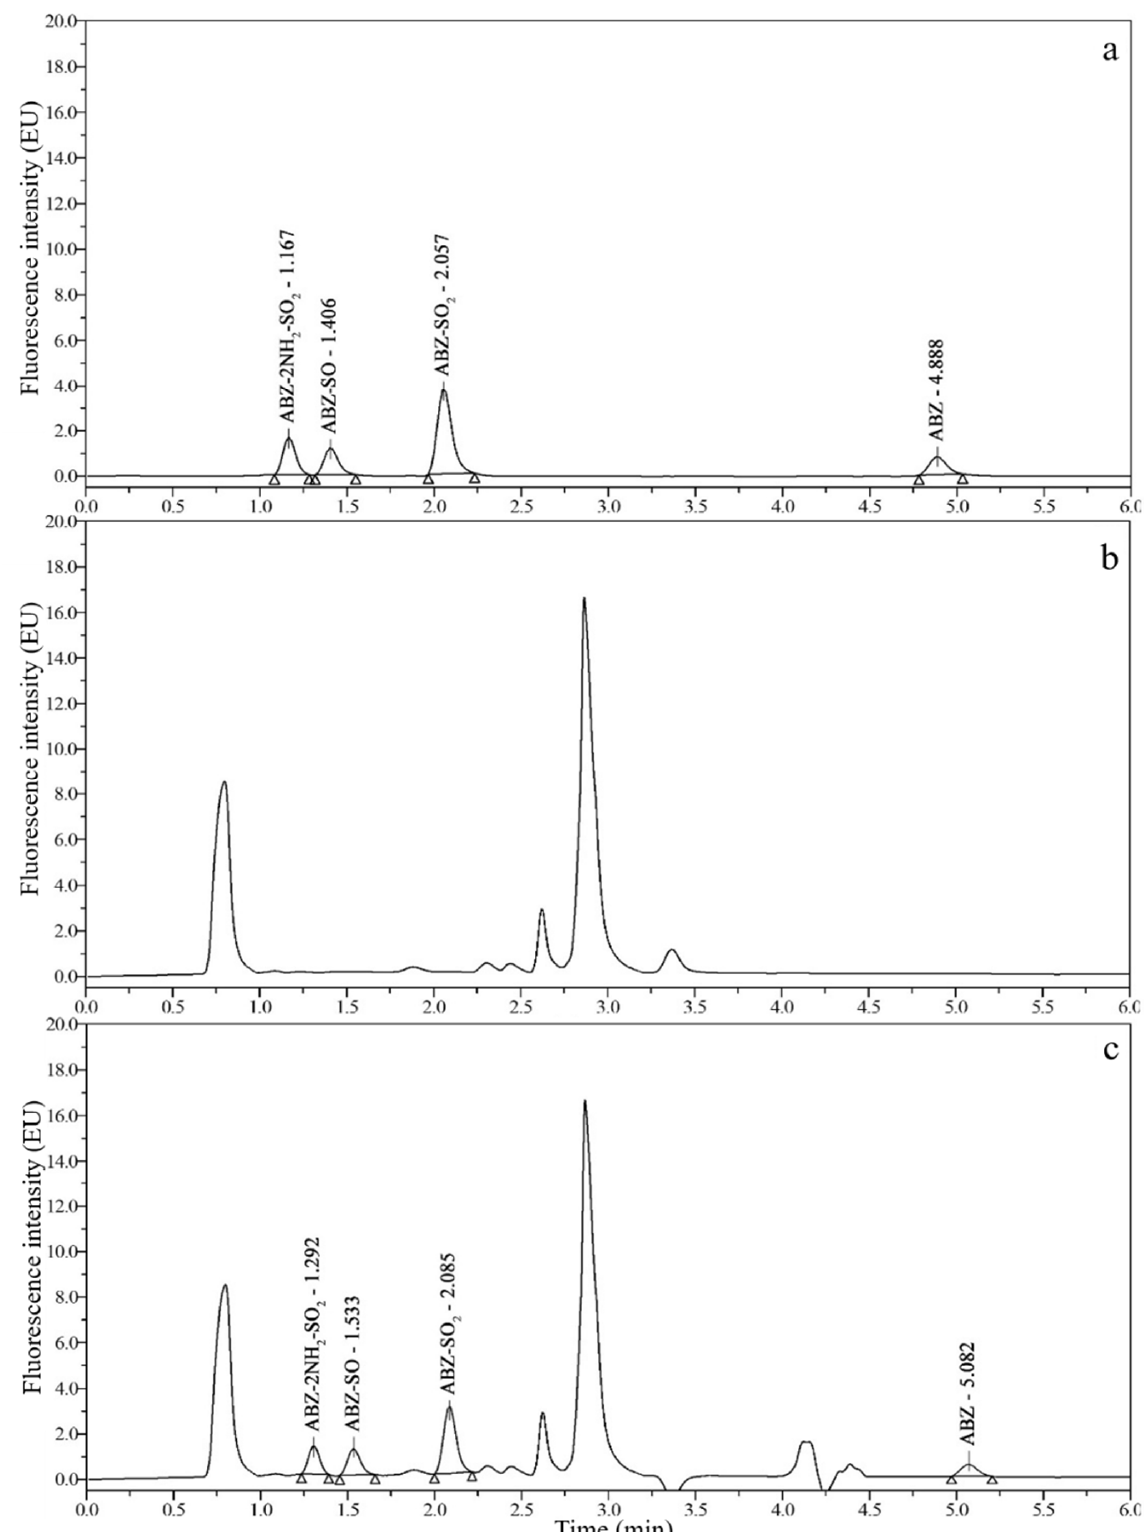
Figure 2. Chromatograms of 10 µ g/kg ABZ-2NH 2 -SO 2 , 50 µ g/kg ABZ-SO, 10 µ g/kg ABZ-SO 2 and 50 µ g/kg ABZ standards ( a ); blank pig muscle ( b ); and blank pig muscle spiked with 10 µ g/kg ABZ-2NH 2 -SO 2 , 50 µ g/kg ABZ-SO, 10 µ g/kg ABZ-SO 2 and 50 µ g/kg ABZ standards ( c ).